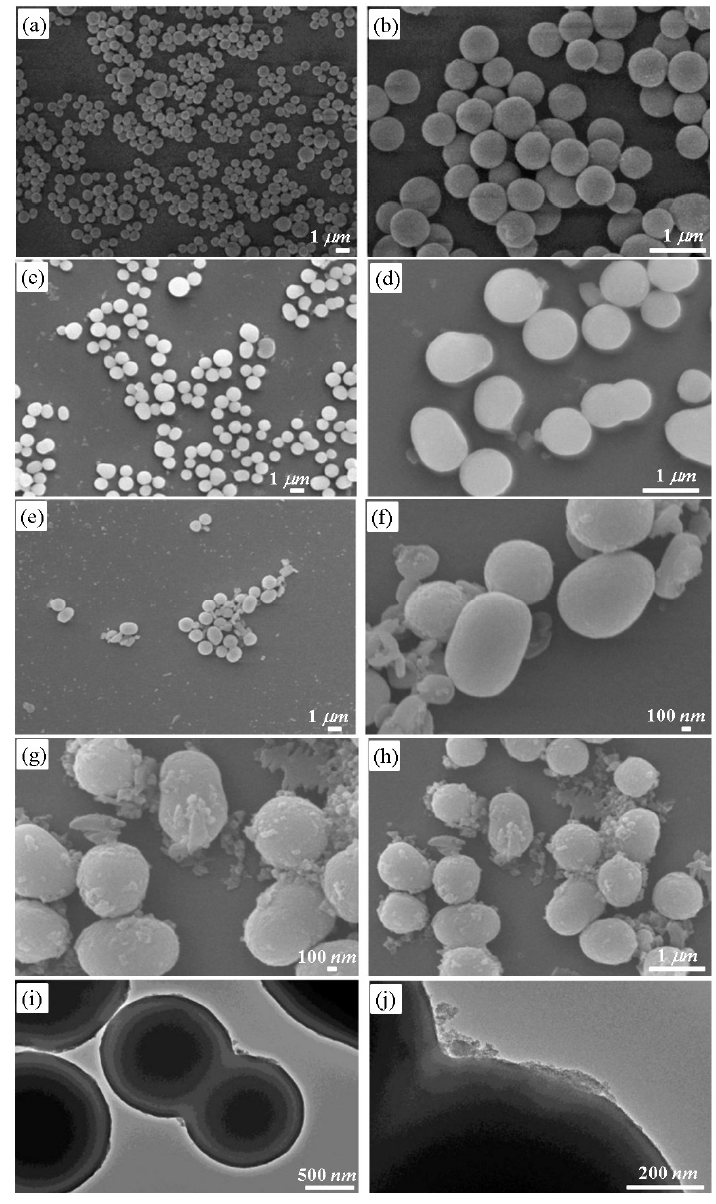
Figure 4. SEM images of ( a , b ) amorphous TiO 2 under different magnifications; ( c , d ) anisotropic peanut-like TiO 2 obtained using glacial acetic acid, ( e , f ) oleic acid. SEM ( g , h ) and TEM ( i , j ) images of anisotropic peanut-like titanium TiO 2 /PANI core/shell nanocomposite. (Tian et al. [117], Copyright Elsevier, 2016).